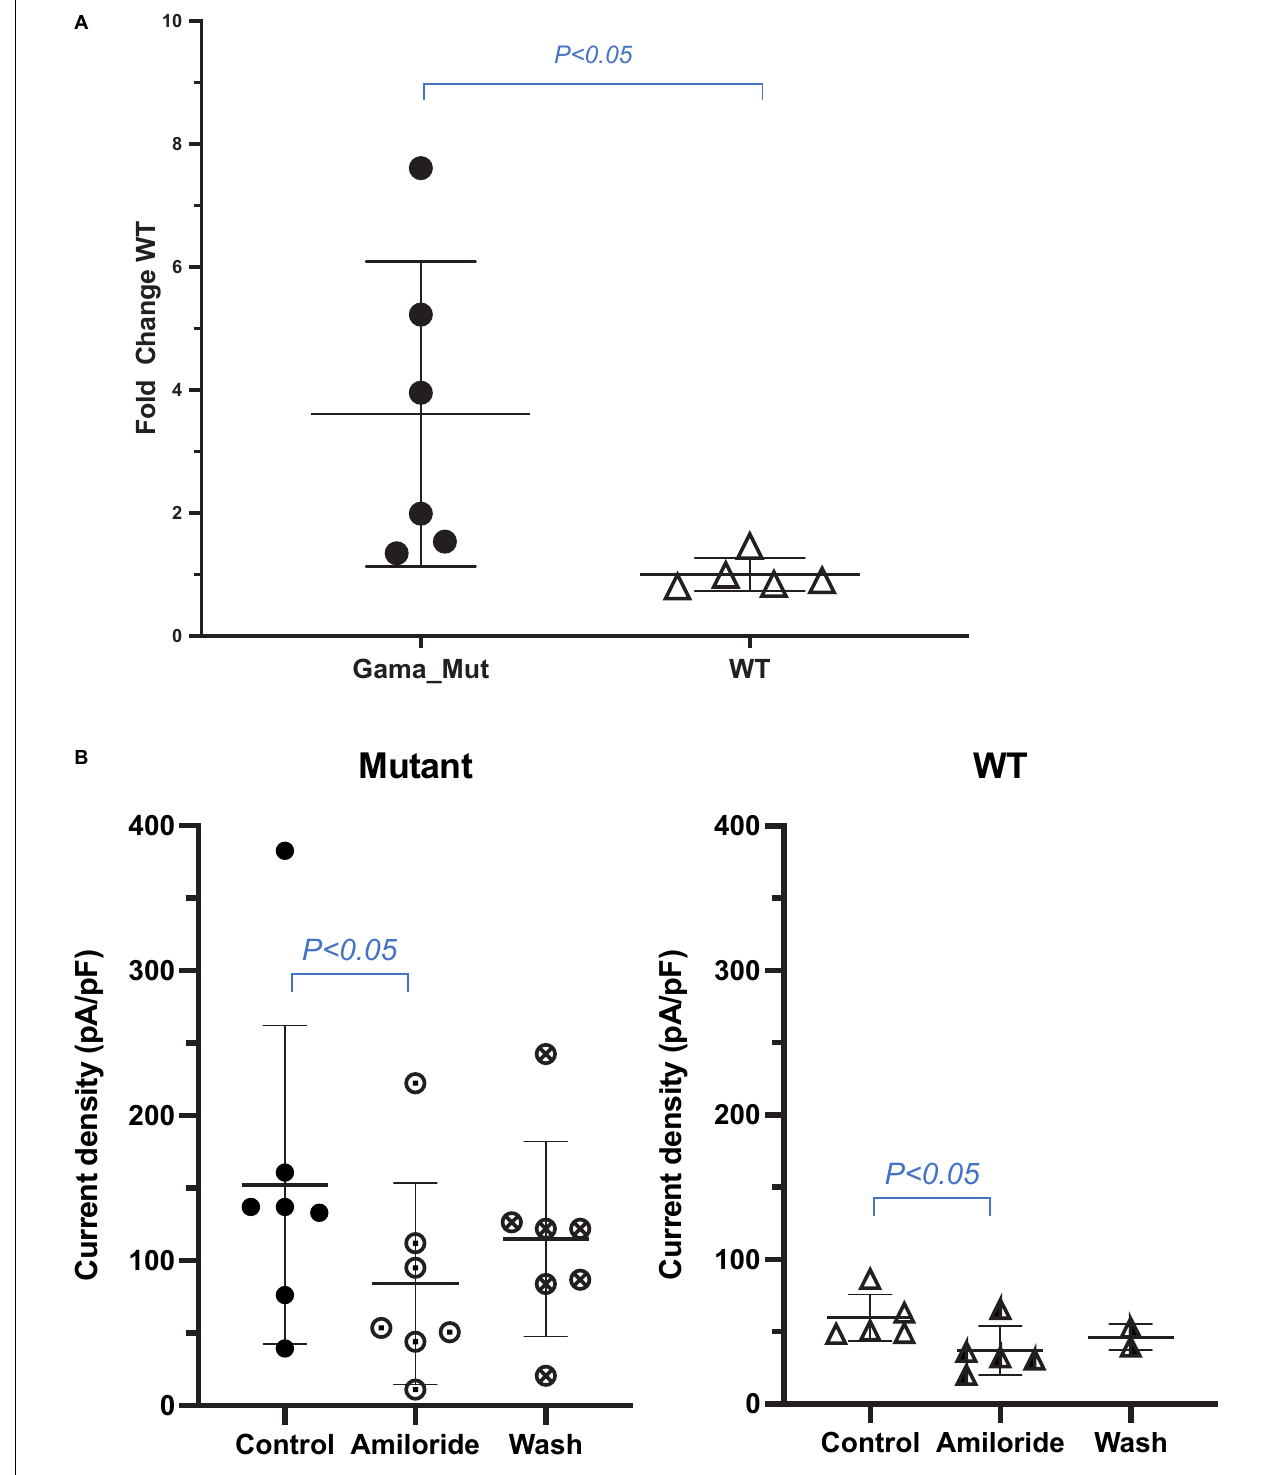
FIGURE 2 | (A) Sodium current between wild and mutant group. Amiloride-sensitive sodium current was increased in CHO expressing mutant ENaC compared with those expressing wild type channels. Values are significantly different between wild type. (B) Amiloride inhibition of sodium current in wild and mutant group. Amiloride-sensitive sodium current was decreased in CHO of mutant ENaC after adding amiloride compared with controlled group. Values are significantly different between with amiloride and without amiloride ( P < 0.05).